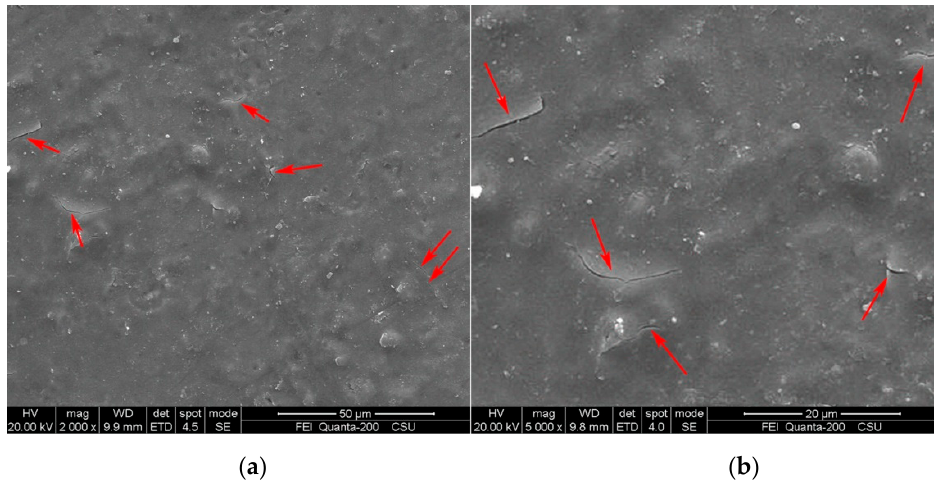
Figure 8. Surface morphology of PEO-S2 after immersion time of 24 h in a 3.5 wt.% NaCl solution. ( a ) magnification with 50 µm; ( b ) magnification with 20 µm;